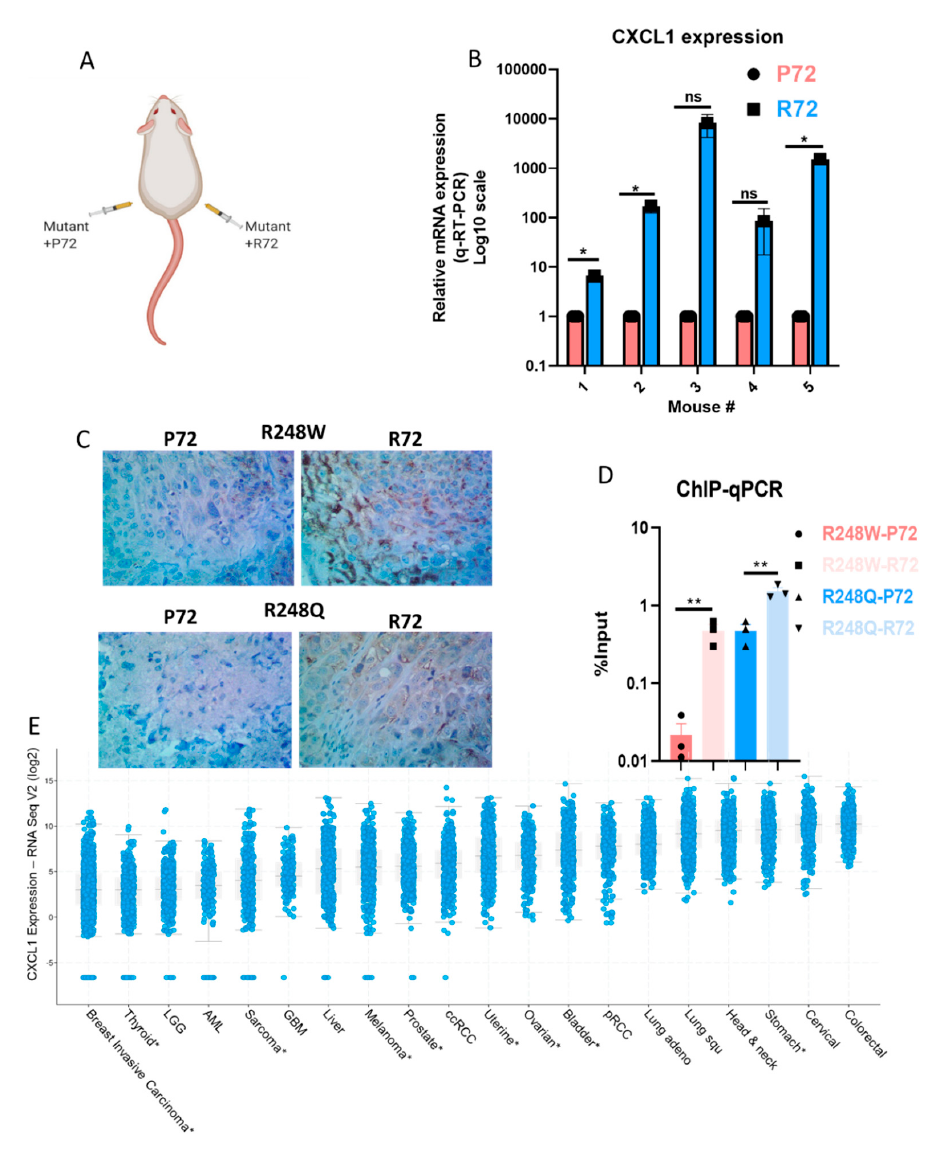
Figure 4. The R72 SNP exhibits higher expression of CXCL1 in animal tissue via enhanced transactivation of CXCL1 ( A ) Schematic describing design of subcutaneous tumor injection in mouse model. ( B ) Gene expression data from RT-qPCR obtained from mouse tumors with the R248W-R72 versus mouse tumors from the R248W-P72 tumors. X -axis denotes the independent tumors with P72 ( n = 5) and R72 ( n = 5). Data are displayed in the Log10 scale. ( C ) CXCL1 expression by immunohistochemistry in tumor xenograft produced by SKOV3 cells transduced with R248W or R248Q mutants with P72 or R72 SNP. ( D ) Chromatin-Immunoprecipitation (ChIP)-qPCR data showing the enhanced binding of p53 mutants with the R72 SNP to the promoter of CXCL1 as a measure of input percentage. ( E ) CXCL1 expression in tumor samples from the Cancer Genome Atlas pan-cancer studies was obtained from the Cbioportal . CXCL1 expression is grouped by tumor type and ordered by median expression. Only data sets with at least 200 tumor samples are included in the plot. Asterisk denotes 2018 pan-cancer data sets. All data shown as mean ± SEM. The statistical analysis was performed using two-tailed Student’s t-test: * p ≤ 0.05, ** p ≤ 0.01.